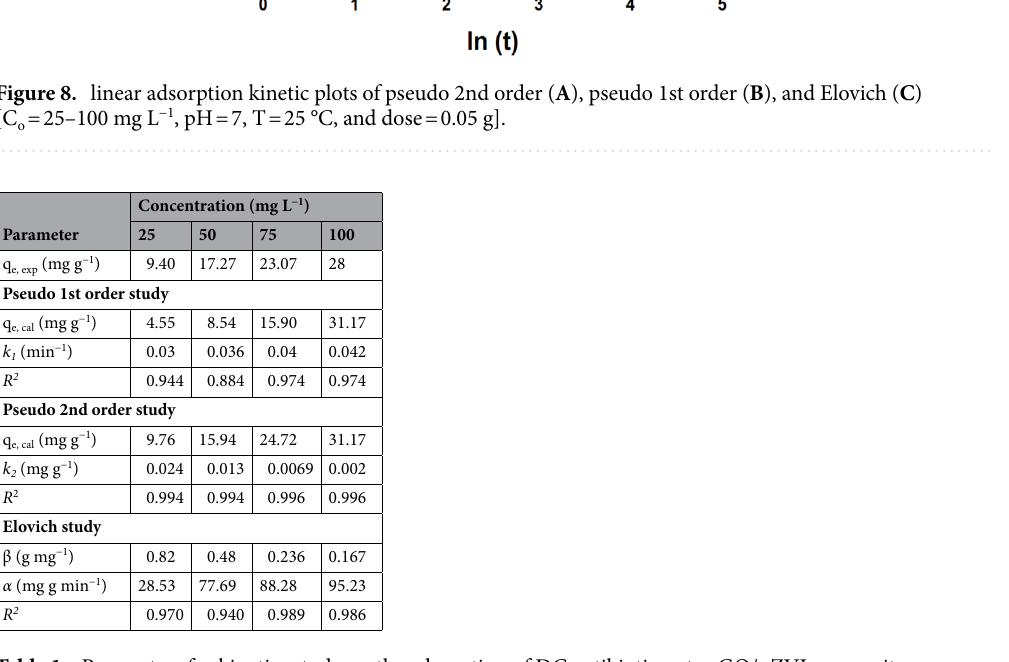
Table 1. Parameters for kinetics study on the adsorption of DC antibiotic onto rGO/nZVI composite.